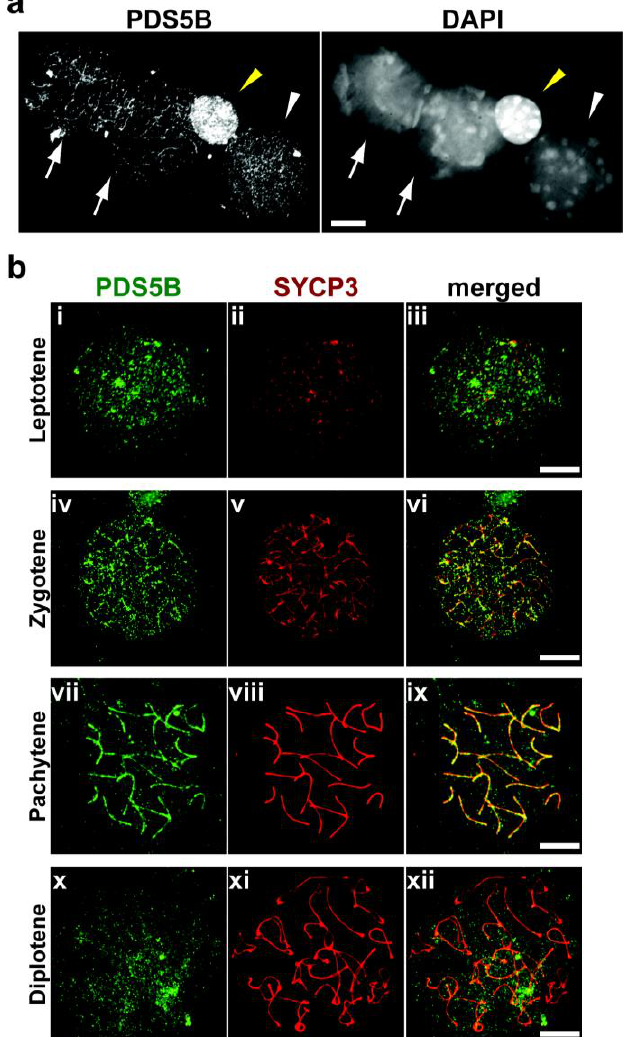
Figure 2. Localization of PDS5B in testicular cells. ( a ) Nuclear spreads of testicular cells stained with anti-PDS5B antibody (left) and DAPI to visualize DNA in nuclei (right). Arrows, pachytene spermatocytes; yellow arrowhead, spermatogonium; white arrowhead, preleptotene spermatocyte. Bar, 10  m; ( b ) Nuclear spreads of leptotene (I to iii), zygotene (iv to vi), pachytene (vii to ix), and diplotene (x to xii) spermatocytes stained with antibodies against PDS5B (green) and an AE component, SYCP3 (red). Bars, 10 